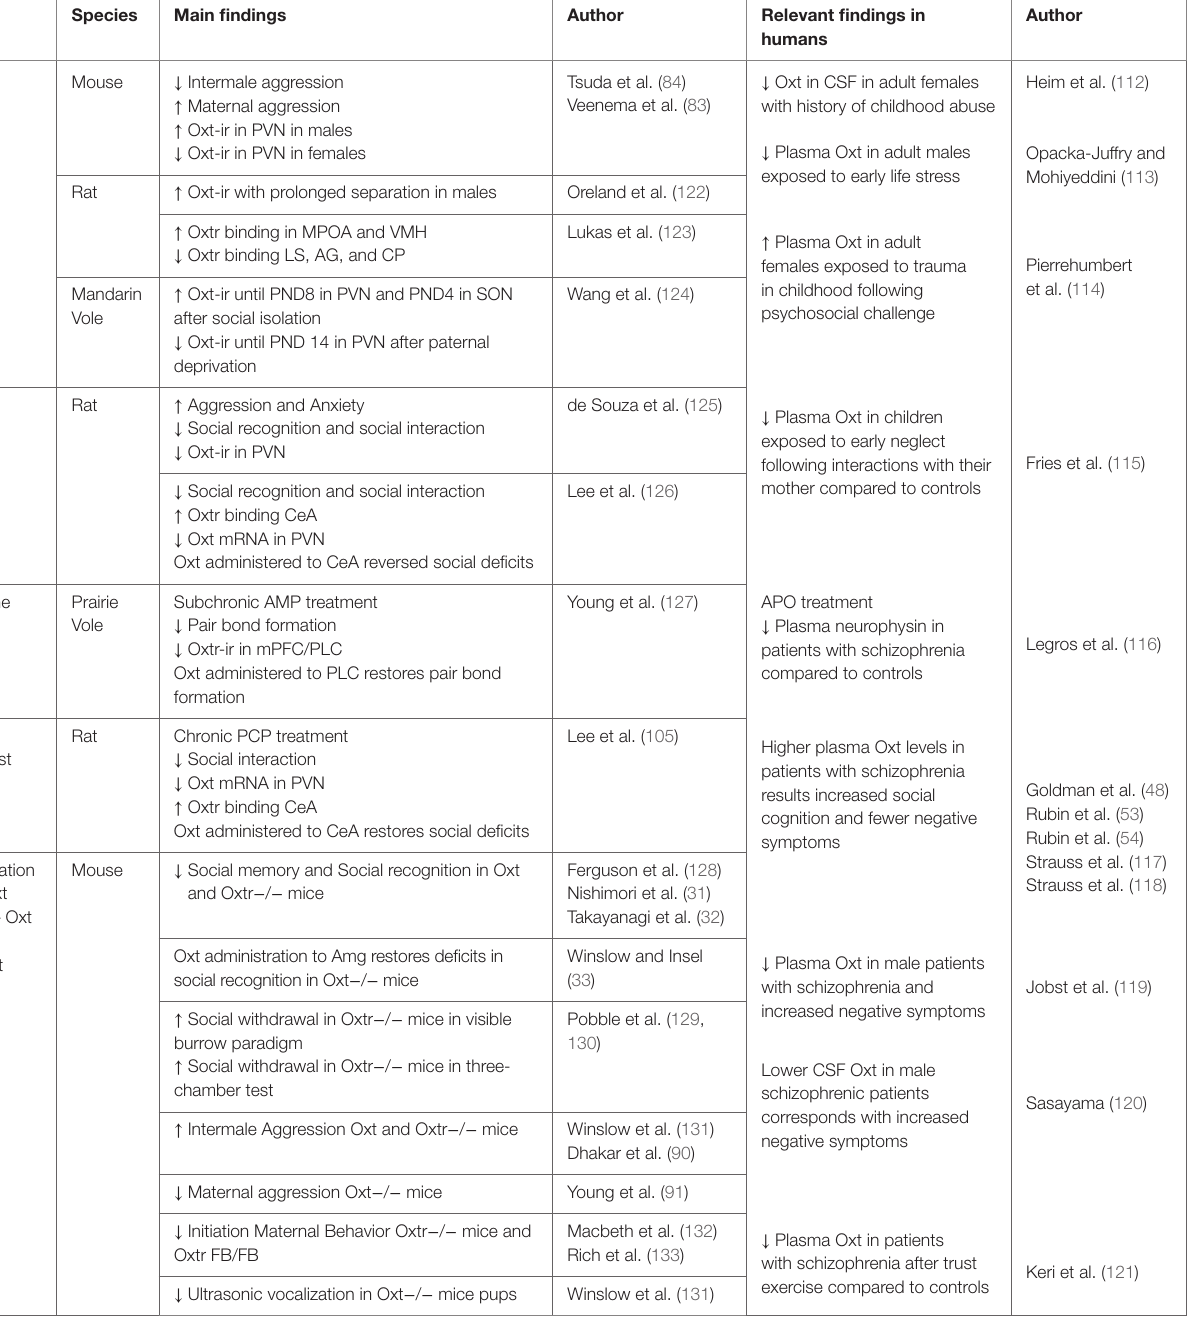
TABle 1 | Oxt and social deficits associated with schizophrenia. Animal